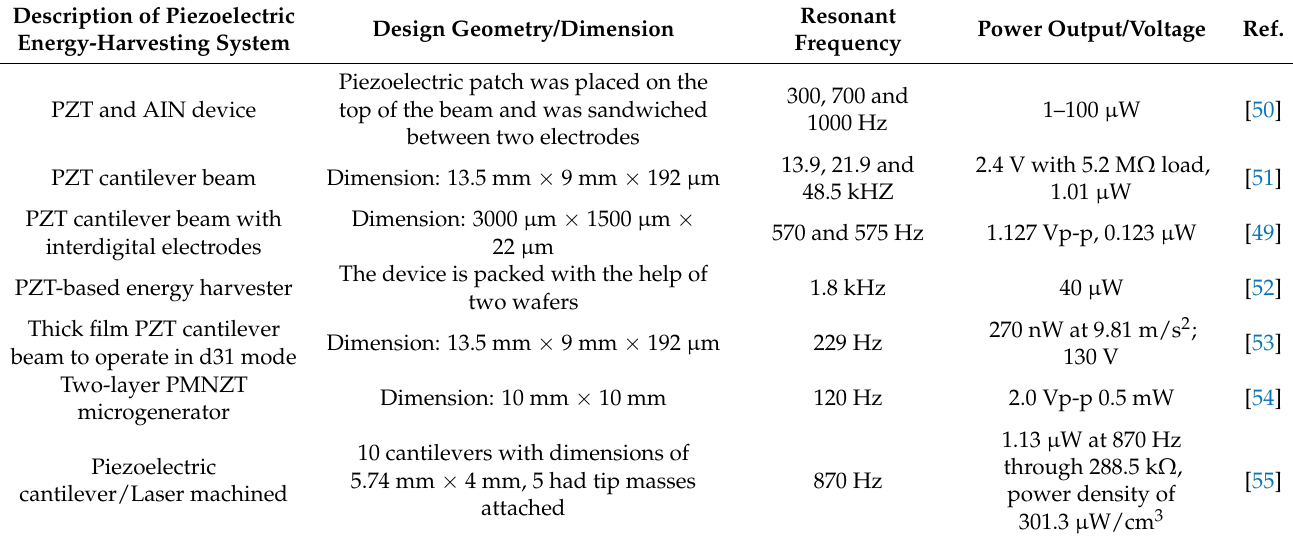
Resonant Power Output/Voltage Ref. Frequency